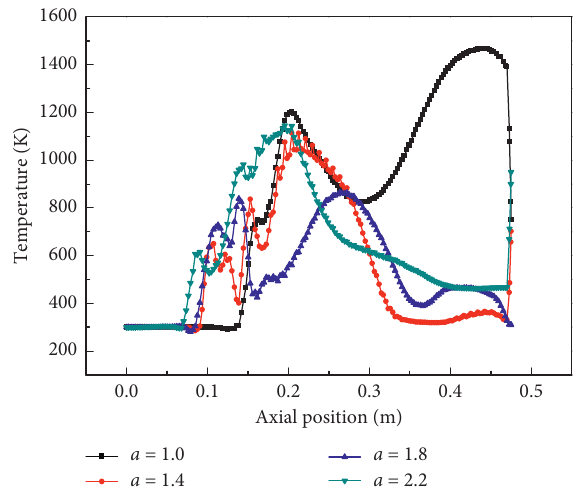
Figure 7: Temperature distribution along the longitudinal cen- terline of the burner under different excess air